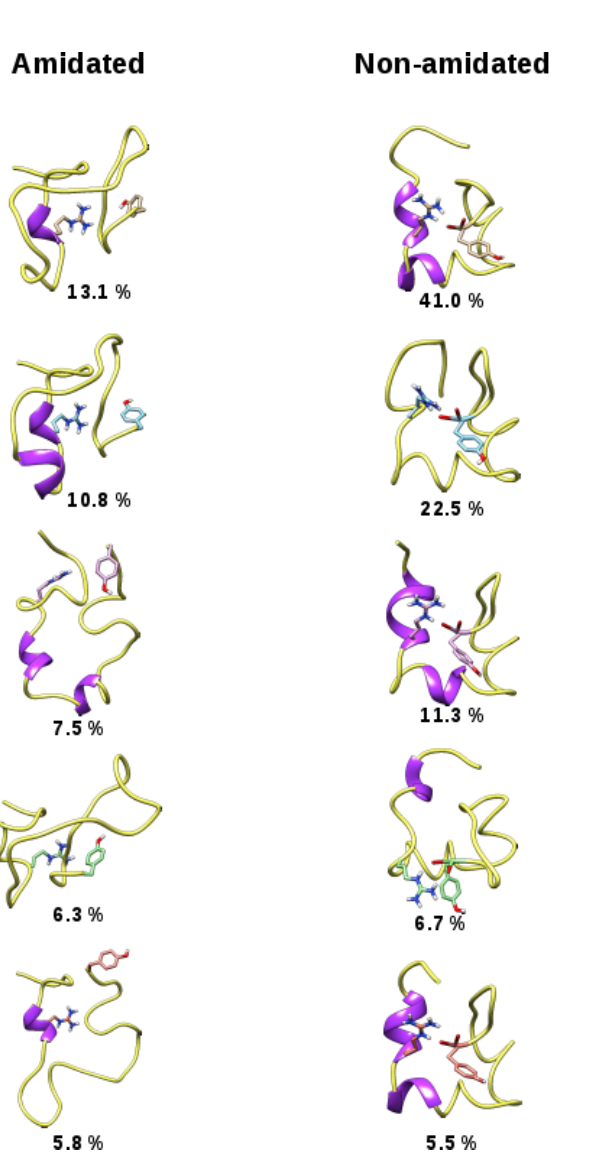
Figure 2. Representative structures of the five most populated clusters calculated from the 1 µ s trajectory of the amidated ( left column) and the non-amidated ( right column) hIAPP peptide. The two residues Arg11 and Tyr37 are highlighted with stick representations.